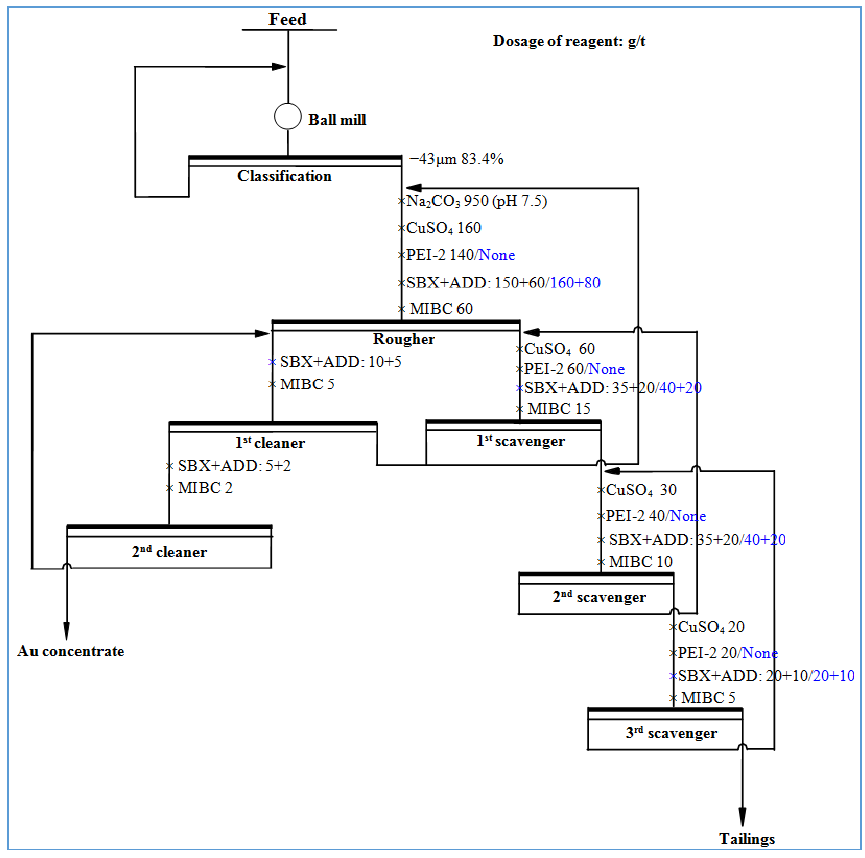
Figure 3. Flowsheet and corresponding conditions of bench-scale locked cycle tests.